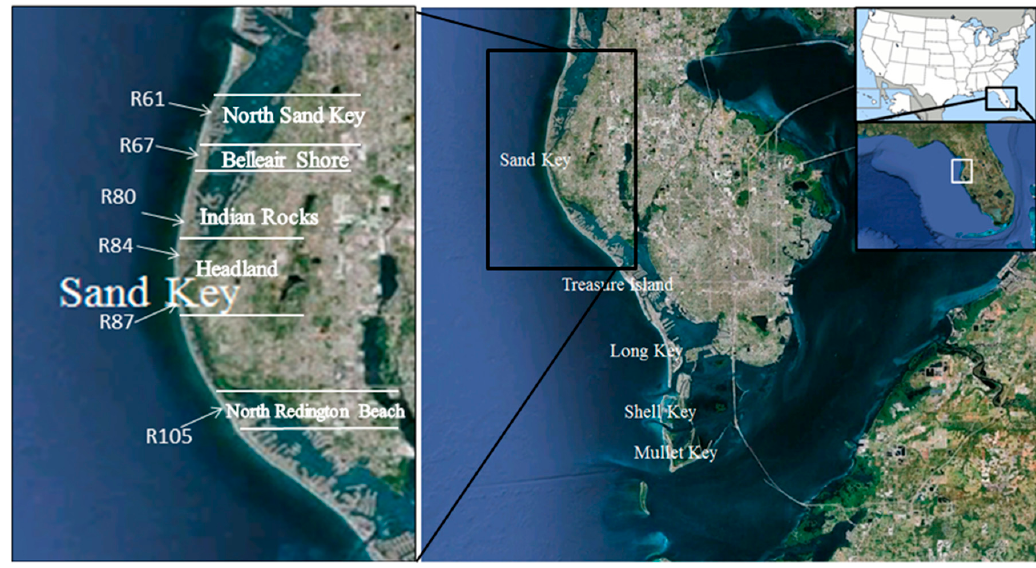
Figure 1. Study area along the coast of west-central Florida.